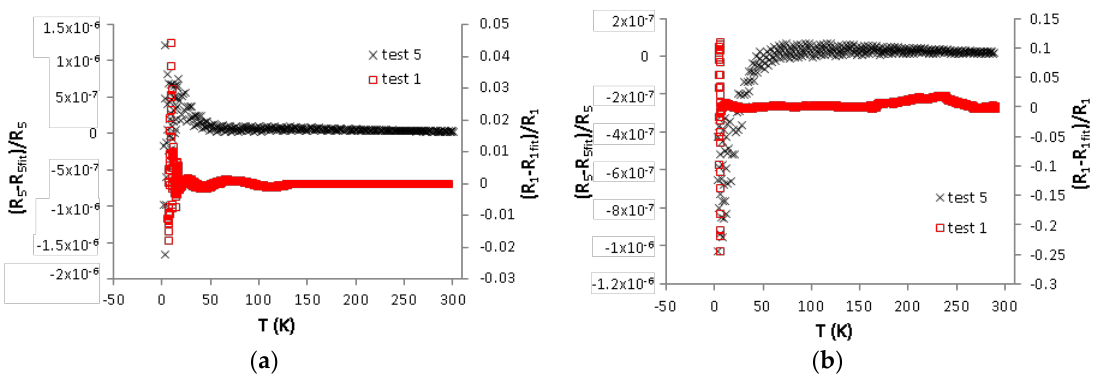
Figure 5. The difference between experimental results and simulated results for: Sensor 1 ( a ); and Sensor 2 ( b ).